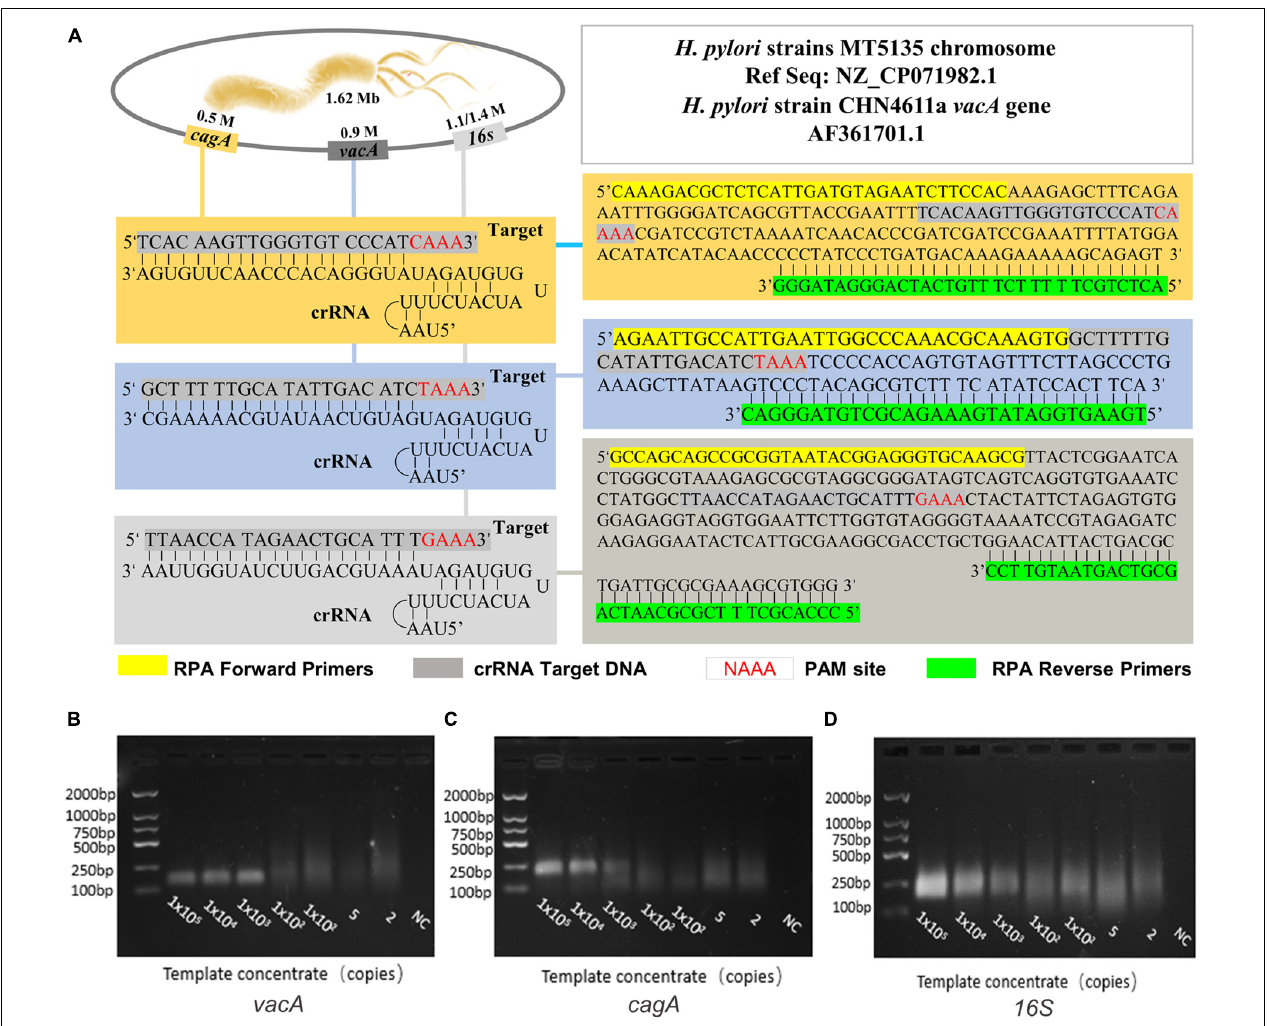
FIGURE 2 | The establishment and optimization of a positive amplification system for H. pylori detection. (A) The genome map shows the target site of the H. pylori vacA , cagA , and 16SrDNA , and it also shows the sequence of crRNA and the location of the RPA primer sequence in this assay. The RPA amplification products (B) vacA , (C) cagA , and (D) 16S were analyzed by agarose gel electrophoresis with the dilution of DNA as a template during amplification.